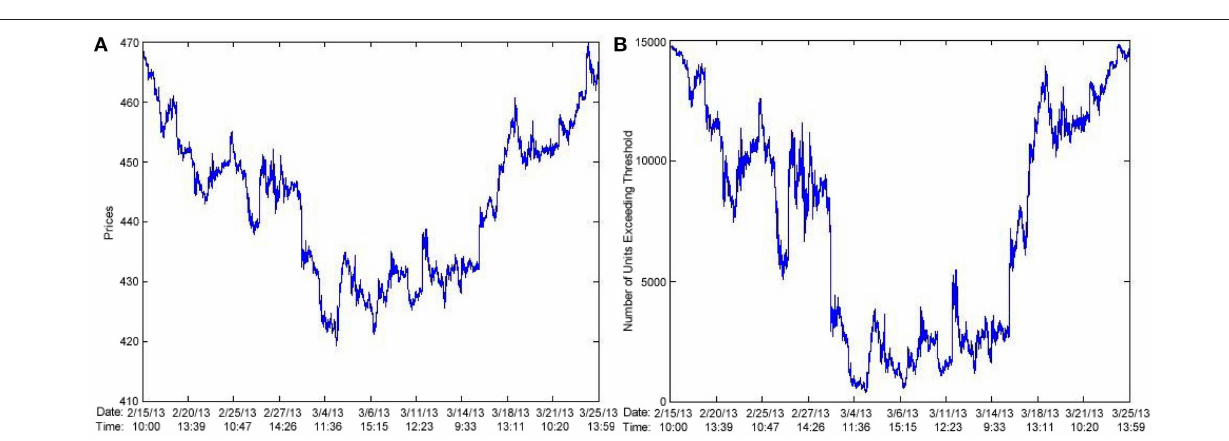
Expected duration spent in regime #1: 5.23 min Expected duration spent in regime #2: 9.48 min Figure 21 shows the state probabilities over